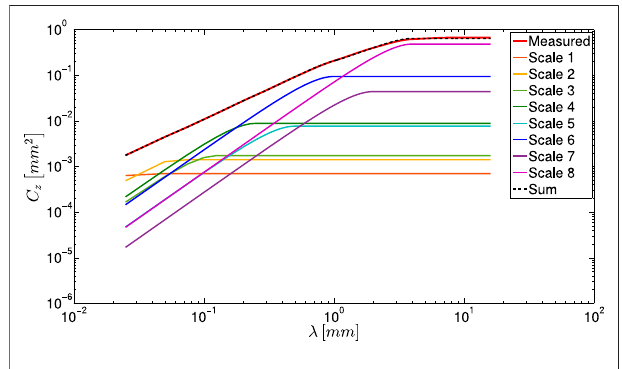
FIGURE 6 | HDC function of asphalt road surface, approximated by the superposition of 8 sinusoidal